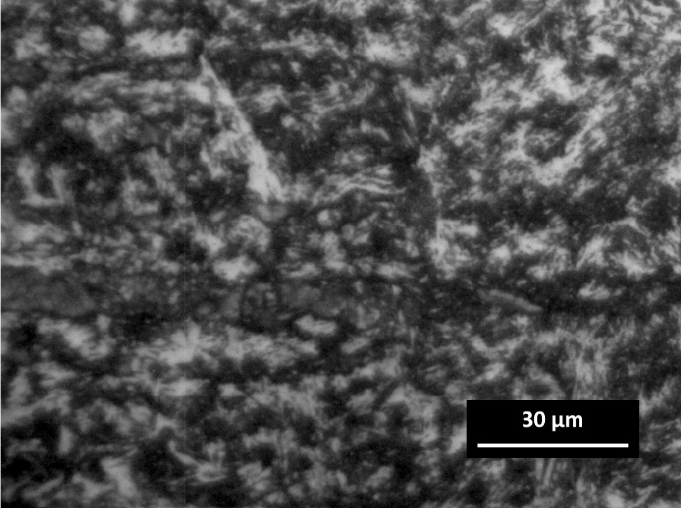
Figure 12. Optical image of untempered martensite in the HAZ of AISI 420.